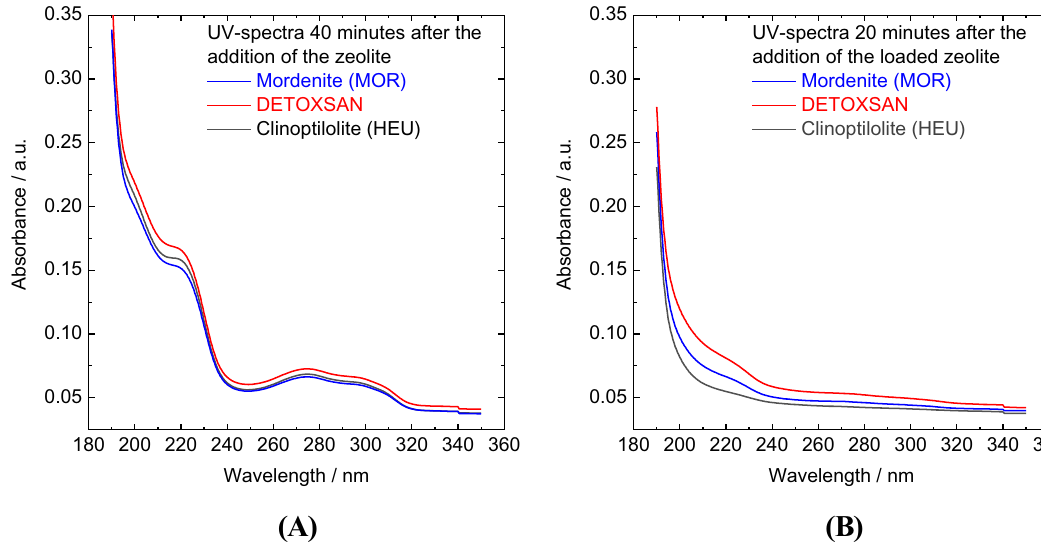
Figure 6. UV–Vis spectra of 5-HT-hc in the liquid phase ( A ) 40 min after the addition of the respective zeolite and ( B ) 20 min after the addition of the respective loaded zeolite into the liquid